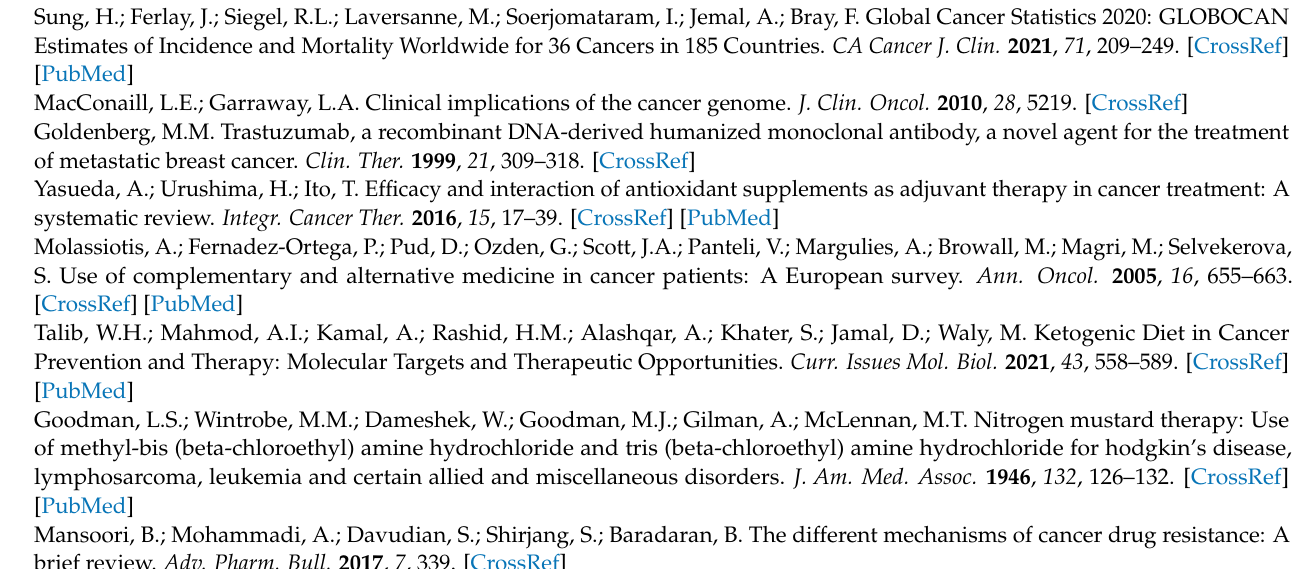
Figure S2: LC-MS Chromatogram obtained from A. citrodora ethyl acetate extract, Figure S3: GC-MS analysis of the hydrodistilled oil, Figure S4: GC-MS analysis of the SPME extracted oil, Figure S5: Major compounds identified in ethyl acetate extract of A. citrodora using LC-MS. 1: